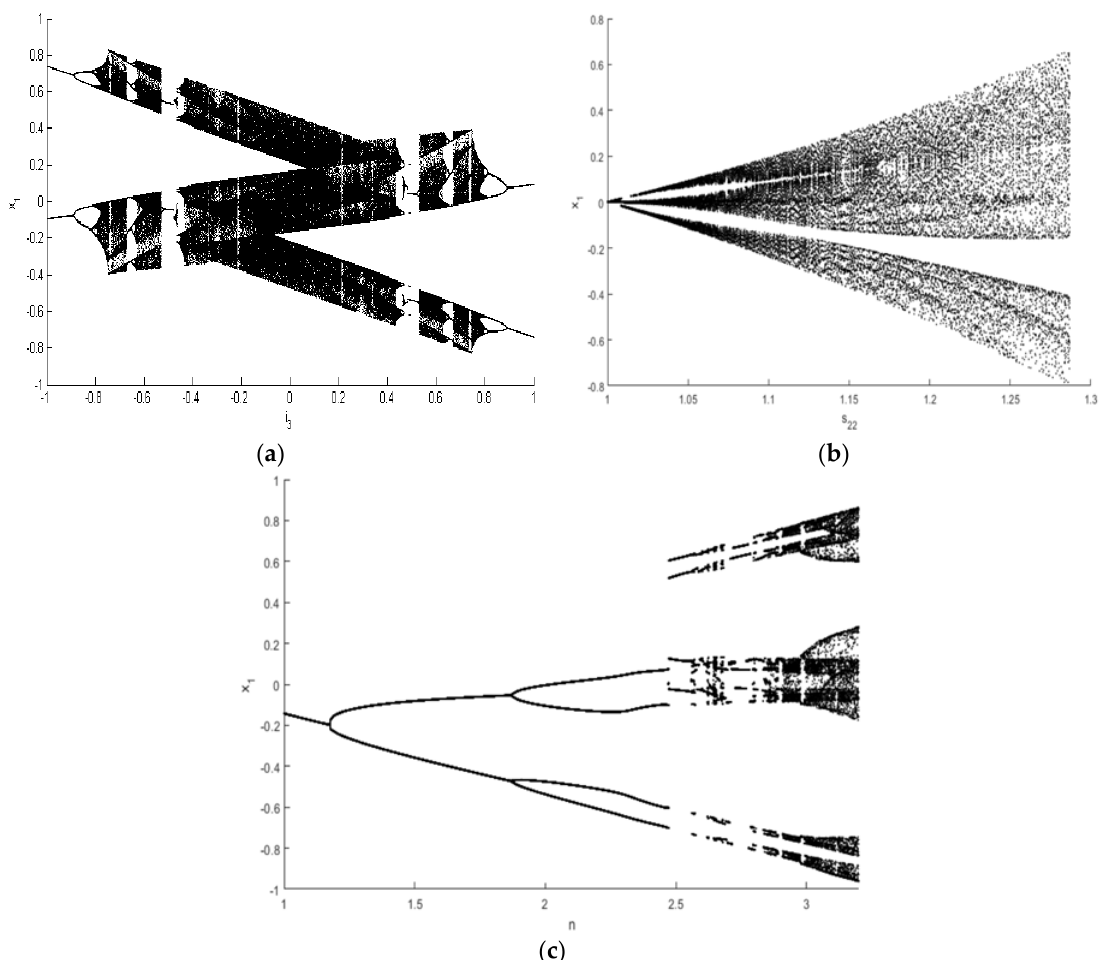
Figure 2. ( a ) Bifurcation study with x 1 versus i 3 ∈ [ − 1, 1] for an increment of Δ i 3 = 0.001; ( b ) bifurcation study with x 1 versus s 22 ∈ [1, 1.3] for an increment of Δ s 22 = 0.001; and ( c ) bifurcation study with x 1 versus n ∈ [1, 3.5] for an increment of Δ n = 0.001.